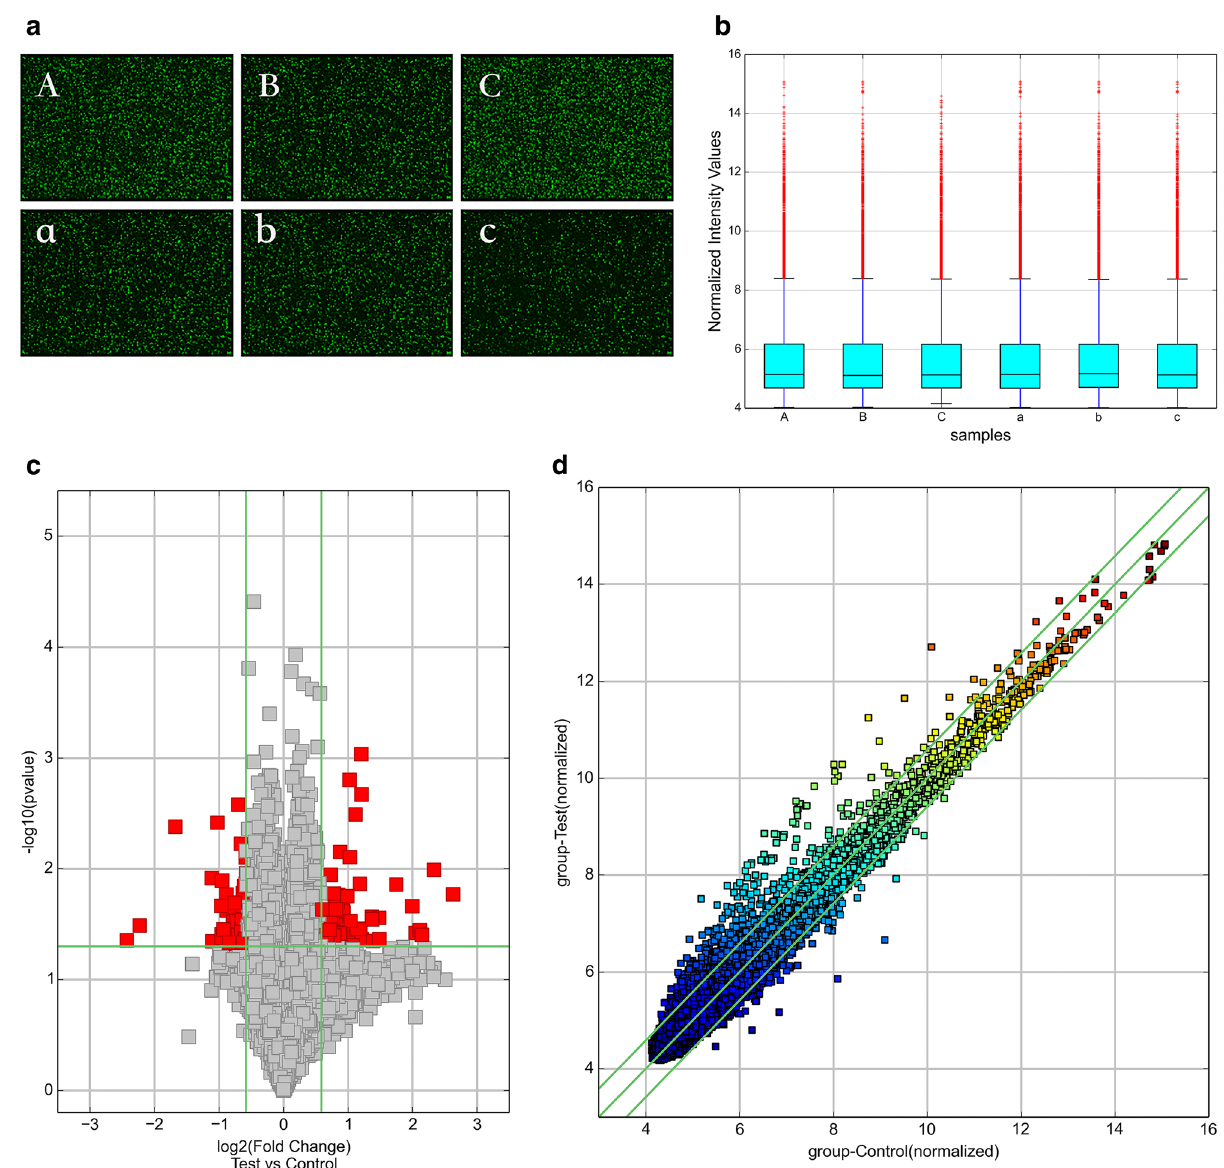
Figure 2. ( a ) The probe fluorescence signal displayed in each microarray scanning picture was uniform and clear. (A, B, C: sepsis group, a, b, c: control group). ( b ) Box plot: The abscissa represents each sample, and the ordinate represents the normalized intensity value. The expression of circRNAs in each sample was almost the same after normalization. ( c ) Volcano map: Differentially expressed circRNAs between sepsis and healthy human serum exosomes. ( d ) Scatter plot: Changes of circRNAs expression levels between sepsis and healthy human serum exosomes. ( e ) Cluster analysis: the distinguishable circRNA expression profile between sepsis and healthy human serum exosomes. The quantile normalisation and difference analysis were performed using limma package (version 3.48.0) in R. The Volcano map and Scatter plot were performed using python (version 2.7). Cluster analysis was performed using gplots package (version 3.1.1) in